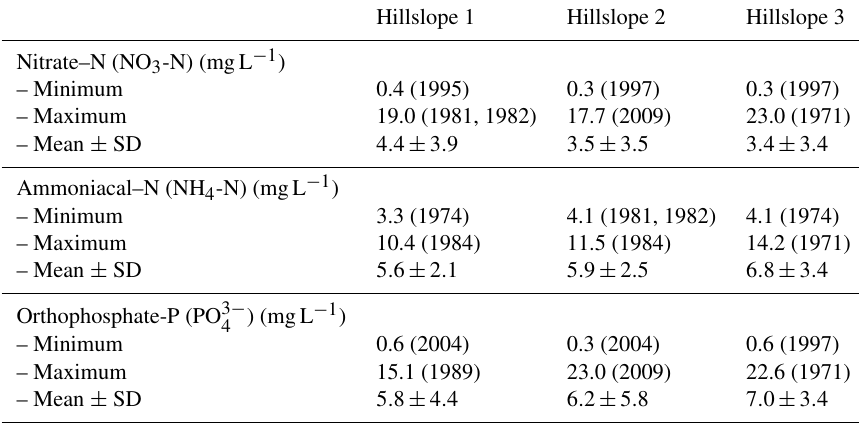
Table 7. Summary statistics of soil nutrient concentration